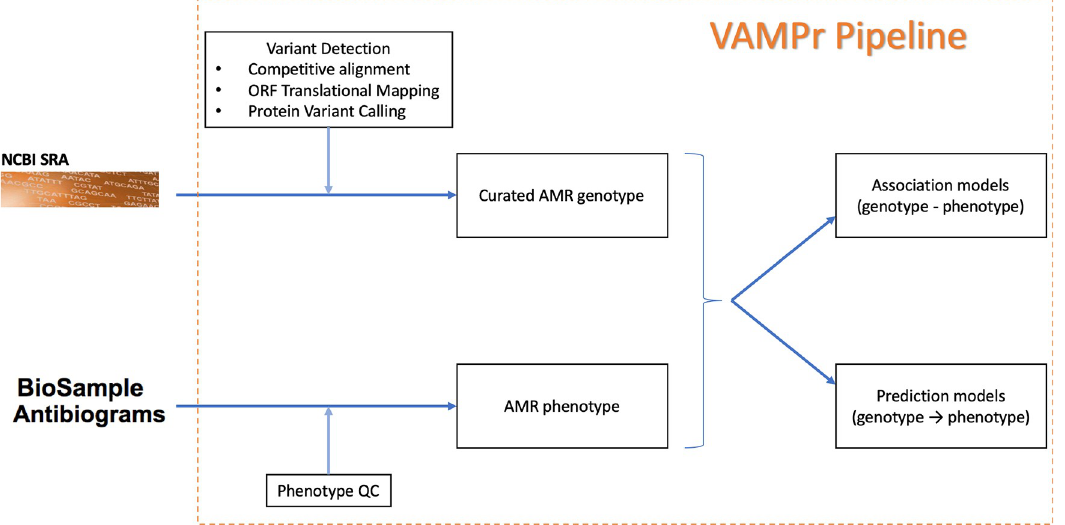
Fig 1. Overview of the VAMPr workflow. The VAMPr pipeline processed sequence data from the NCBI Short Read Achieve (SRA) and NCBI BioSample Antibiograms for phenotypes. The curated AMR genotypes and AMR phenotypes were used to create both association and prediction